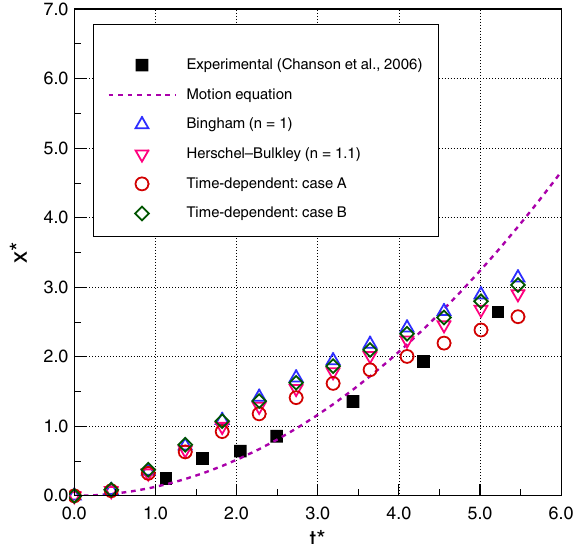
Figure 8. Thixotropic avalanche case 2: comparison of numerical results and experimental data for non-dimensional front displace- ment ( x ∗ ) as a function of non-dimensional simulation time ( t ∗ ).